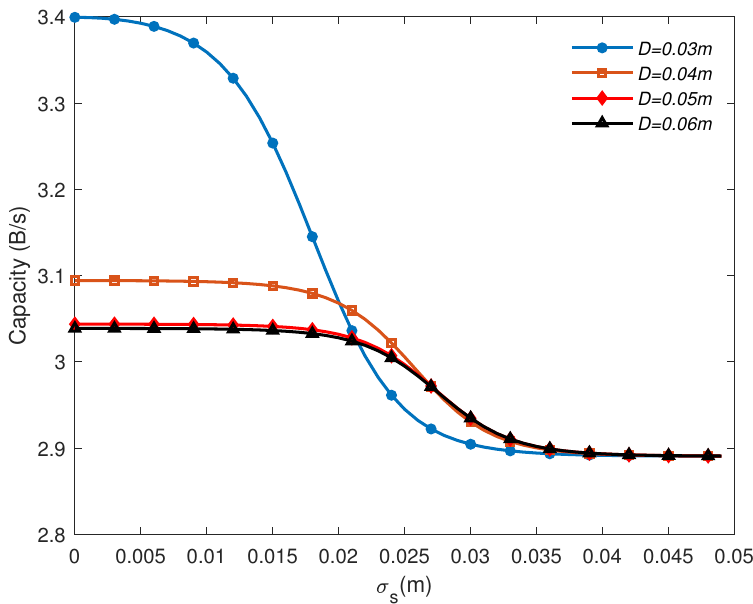
Figure 6. Information capacity of OAM channels versus the half-beam width and pointing errors.